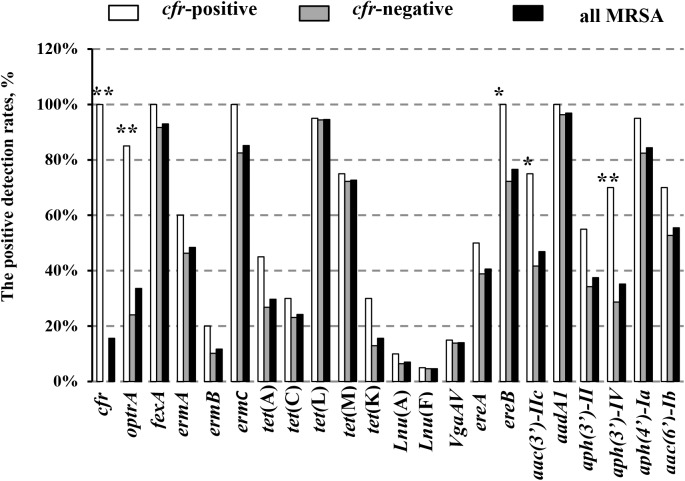
Positive detection rates of genes related to antibiotic resistance in the study MRSA strains. Detection rates between the cfr-positive and cfr-negative MRSA strains were determined using the χ2 test. ∗P < 0.05; ∗∗P < 0.01 cfr-positive MRSA strains vs. cfr-negative MRSA strains.